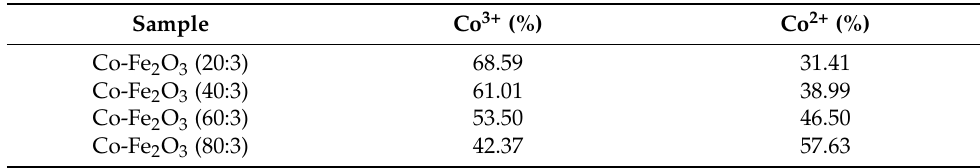
Figure 4. The XPS of Co 2p spectra for ( a ) Co-Fe 2 O 3 (20:3), ( b ) Co-Fe 2 O 3 (40:3), ( c ) Co-Fe 2 O 3 (60:3), and ( d ) Co-Fe 2 O 3 (80:3). Table 1. The XPS of integrated value for Co 3+ and Co 2+ .